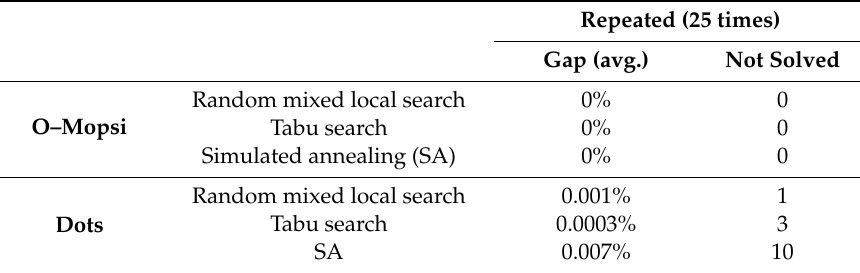
Table 4. Comparison of Tabu search and simulated annealing (SA) result with random mixed local search result with the same iteration and repetition for O–Mopsi and dot instances.